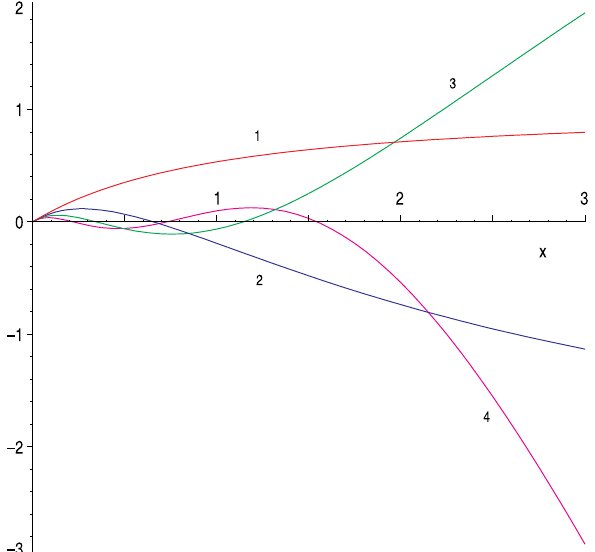
Fig. 3 Plot of the first four eigenfunctions for the case μ = 0 . 1, λ = 1 at small